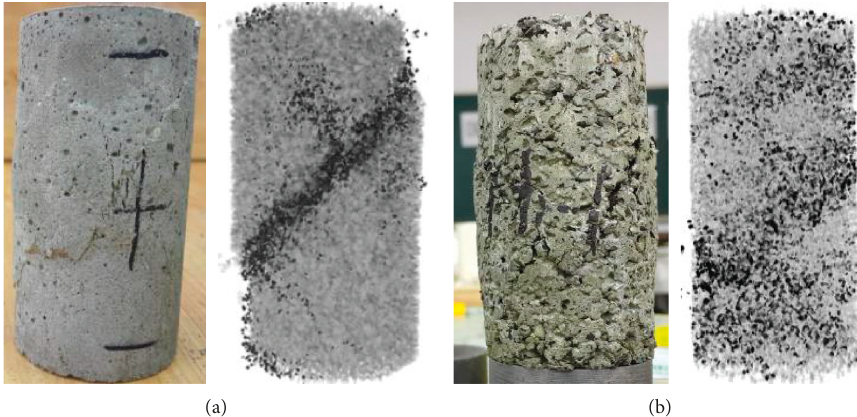
Figure 9: The contrast figure of fracture morphology of laboratory (left) and simulation (right). (a) NC, 0% rubber. (b) CRC, 40% rubber. Table 3: Mesomechanical parameters of the CRC.